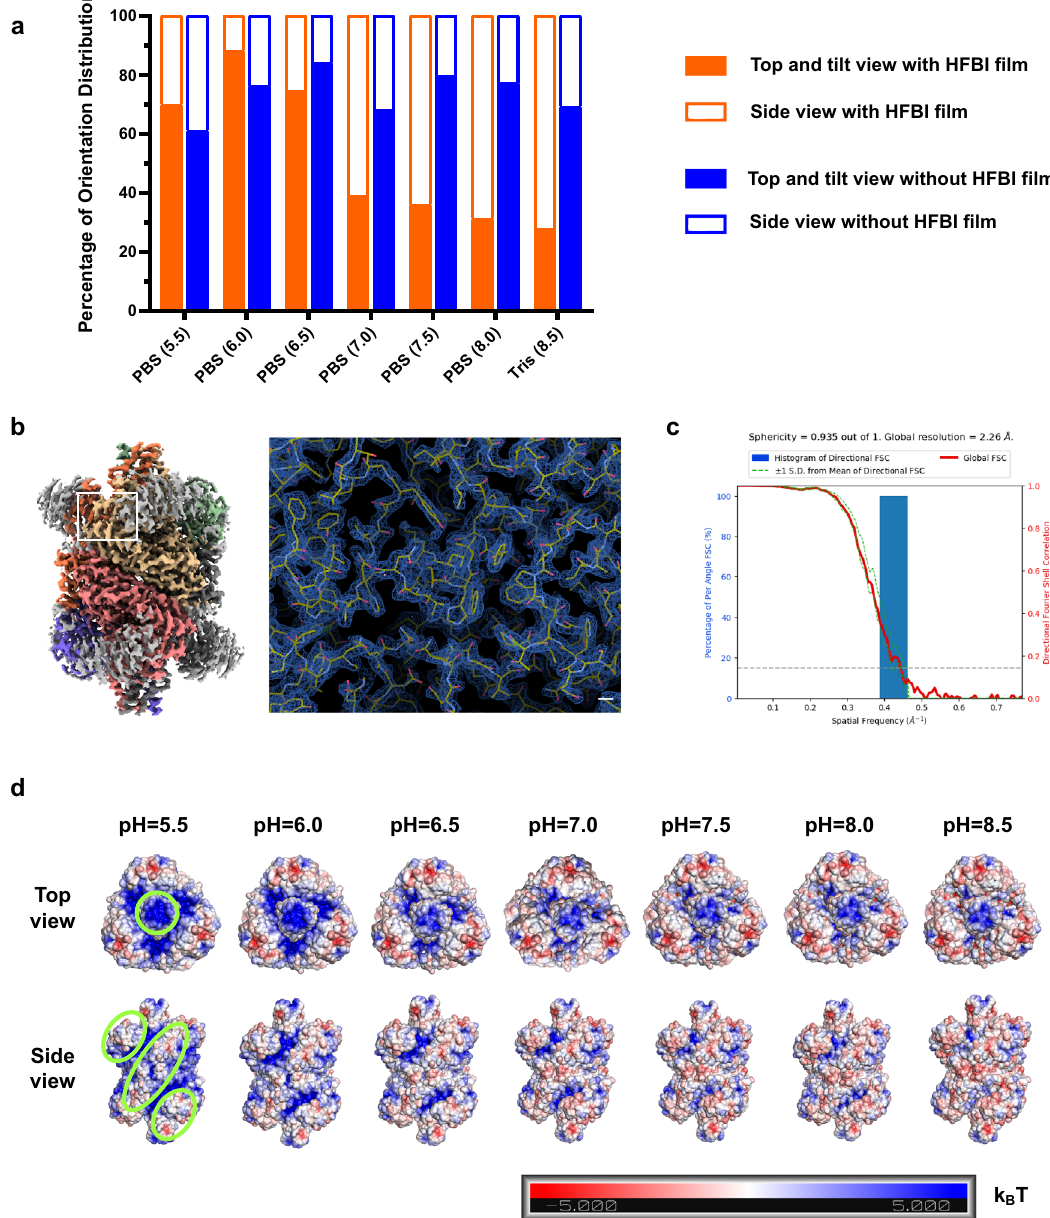
Fig. 5 Regulating particle orientation distribution by changing the buffer condition. a The statistics of percentages of different GDH views in different buffer conditions. PBS phosphate-buffered saline. Tris, Tris buffer (20 mM Tris – HCl and 150 mM NaCl). The pH value of each buffer is shown in brackets. b The 2.26 Å resolution cryo-EM map of pH 7.5 buffered GDH that was solved using the HFBI fi lm covered ANTA foil grid, and a representative region of the cryo-EM map is magni fi ed (right) with the fi tted atomic model. Scale bar, 2 Å. c 3D-FSC plot of cryo-EM reconstruction of pH 7.5 buffered GDH using the HFBI fi lm covered ANTA foil grid. d The electrostatic potentials of GDH at different pH values are mapped onto its solvent-accessible surface. The electrostatic potentials are coloured from red (negative charge) to blue (positive charge) in the range of − 5.0 to 5.0 k B T . Green circles highlight the regions attached to the HFBI fi lm at the corresponding